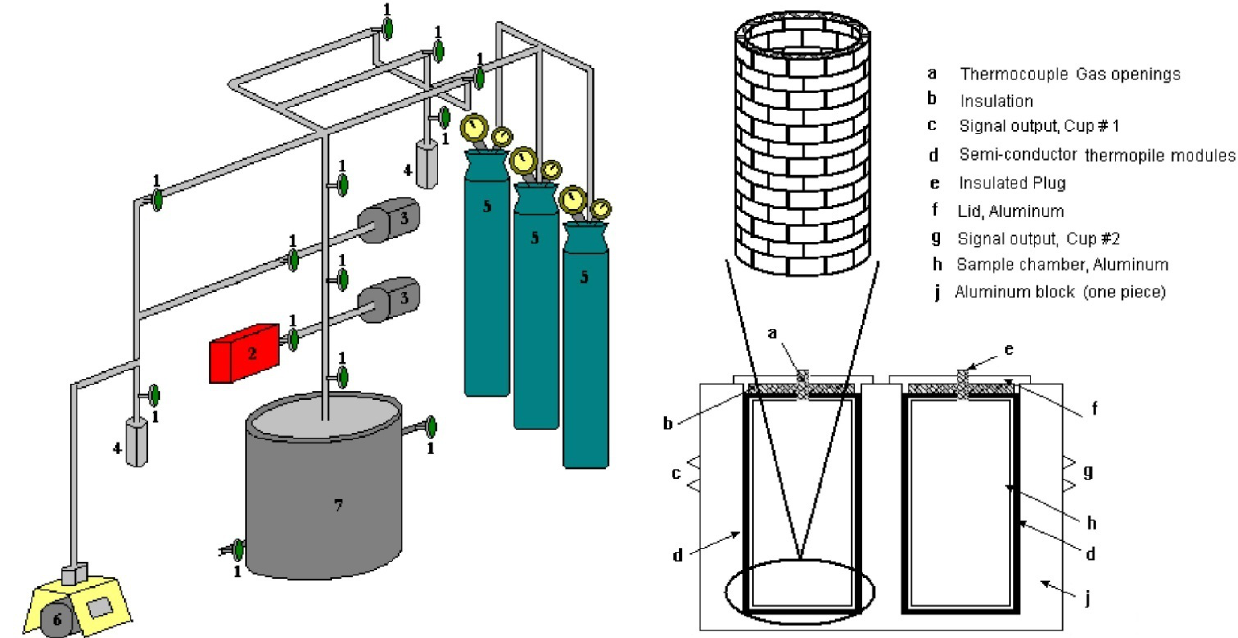
Figure 5. Schematic of an adsorption microcalorimeter: 1. Precision valves, 2. Calibration volume, 3. Pressure transducter of full pressure, 4. Cold Trap, 5. Injection